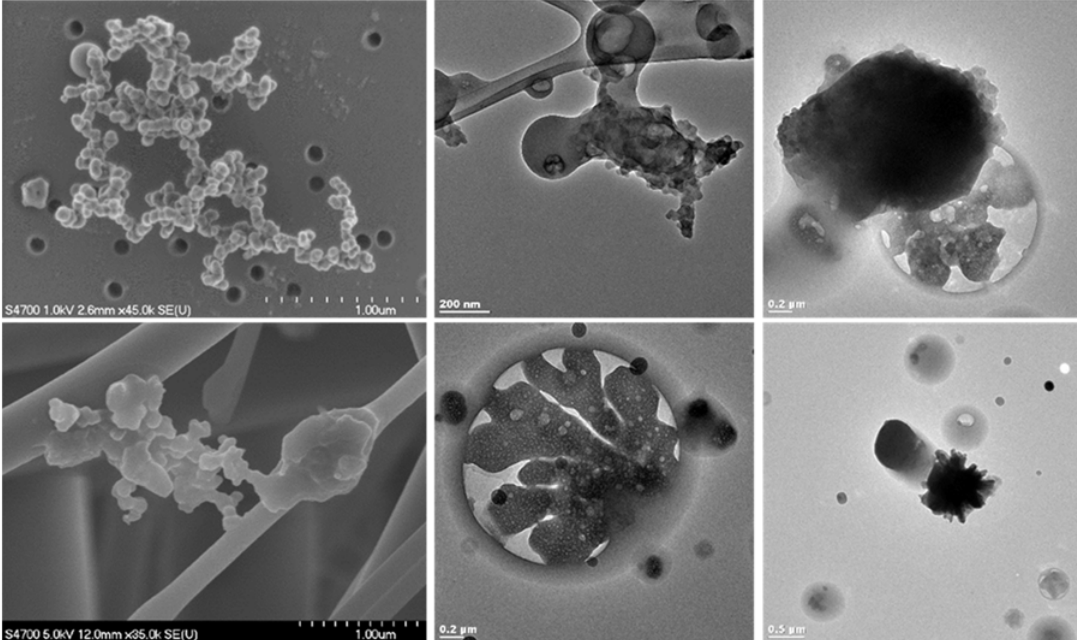
Figure 1. Complex morphology and internal mixing of atmospheric particles.